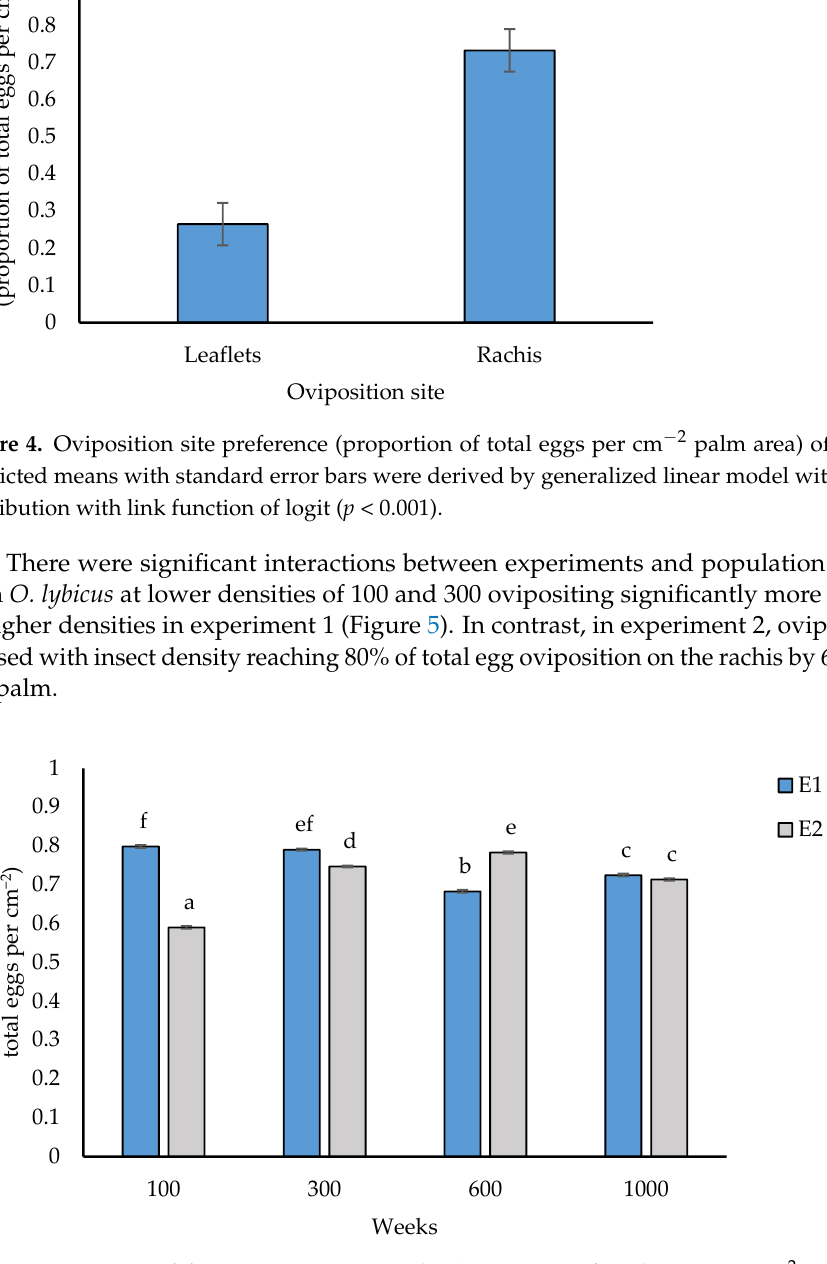
7 of 16 Figure 3. Honeydew secretion by different initial populations of O. lybicus in the period of eleven weeks following insect release. Predicted means with standard error bars are shown from general- ized linear mixed model analysis for negative binomial distribution with link function of log ratio